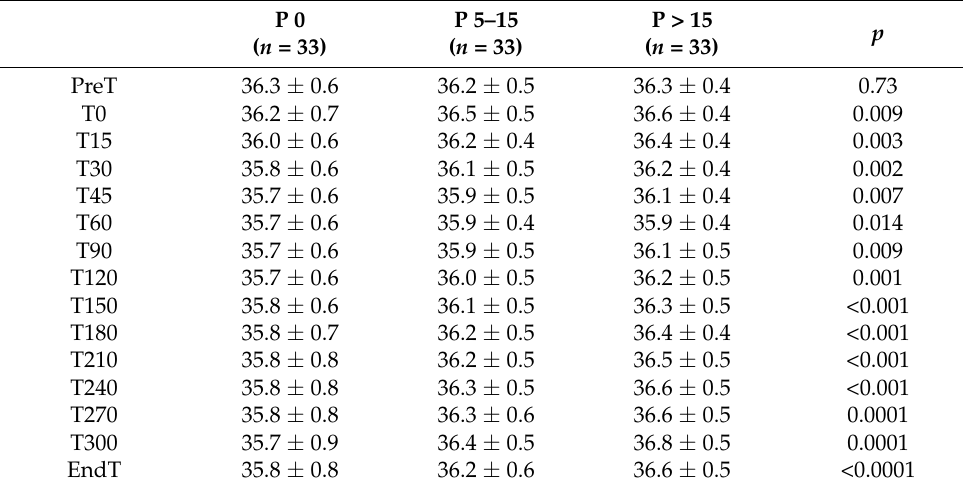
Table 2. Perioperative core temperature